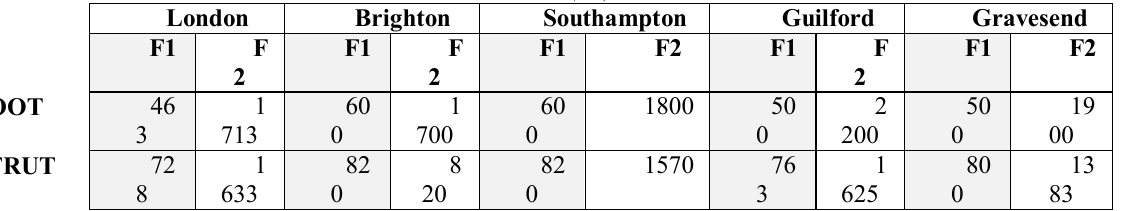
Table 1 – The mean F1 and F2 values of FOOT and STRUT variables of five young females from the South and South